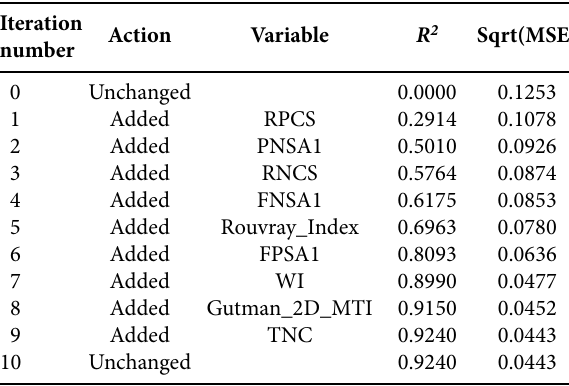
Table 1. The results of stepwise selection